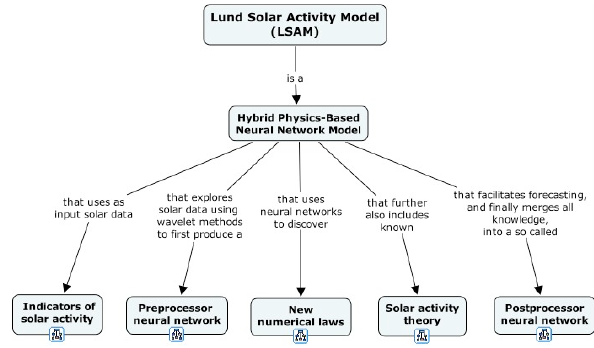
Fig. 1. The scientific approach of our program.